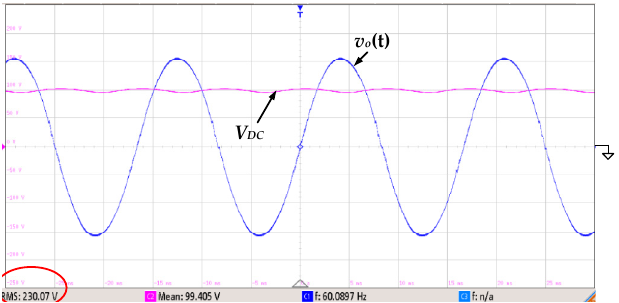
Figure 19. The experimental waveforms of the output voltage v o ( t ) and input voltage V DC at 230 V rms output and 100 V input ( v o ( t ): 100 V/div; V DC : 50 V/div; time: 5 ms/div).